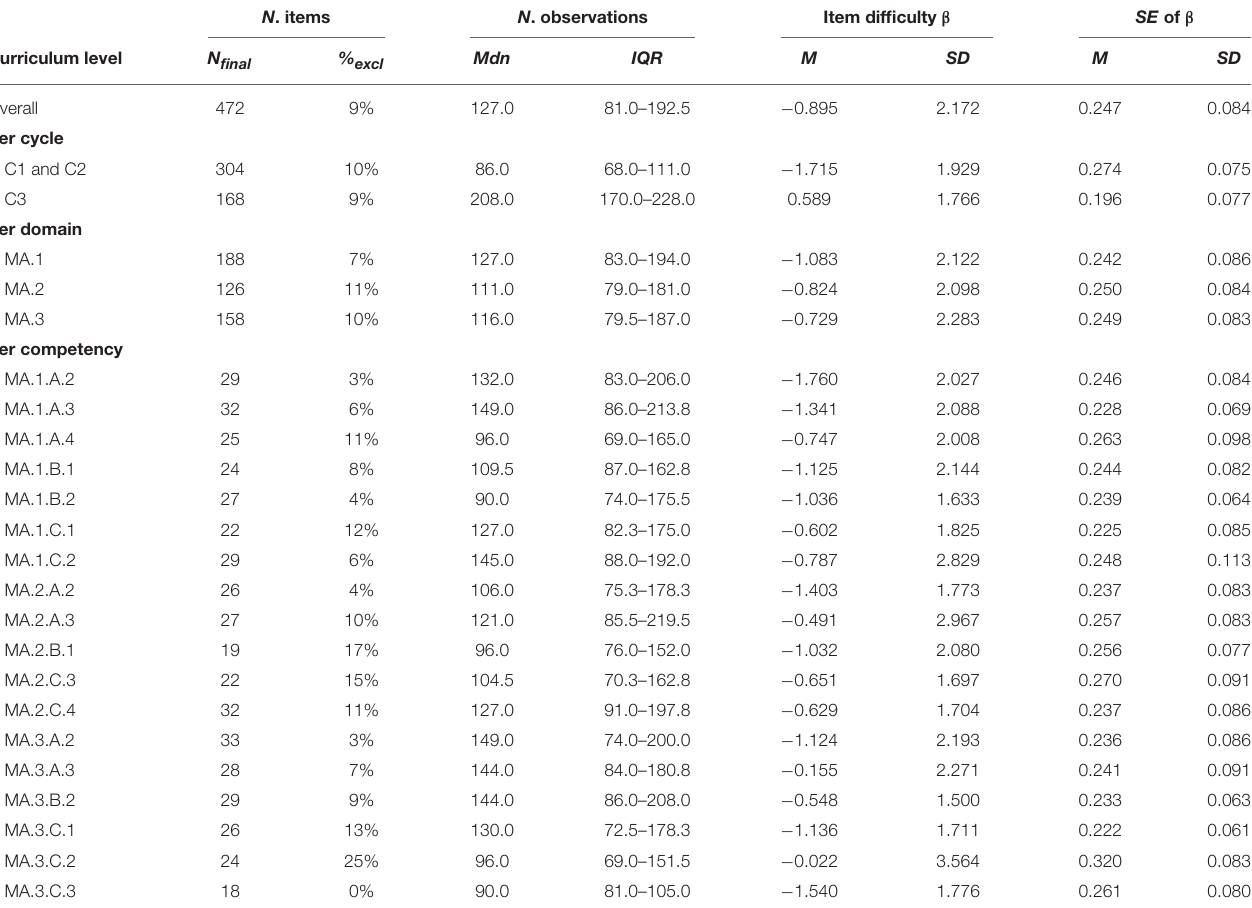
TABLE 5 | Final item pool’s descriptive